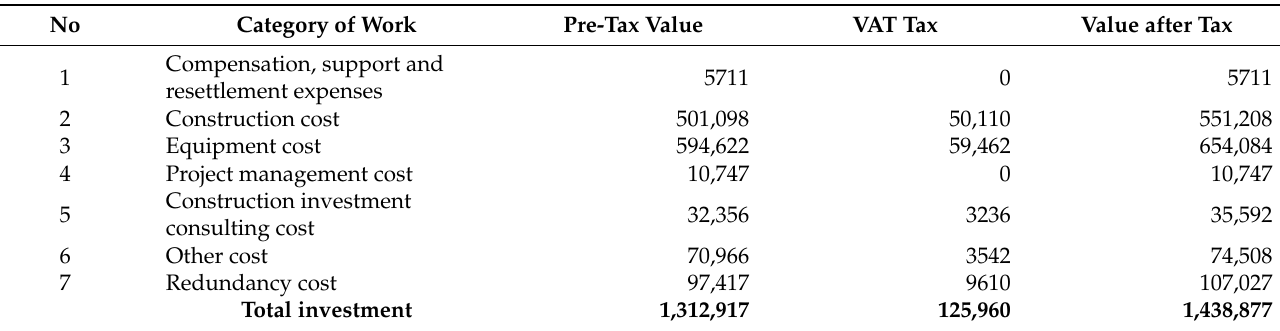
Table 5. Total investment amount (Unit: million